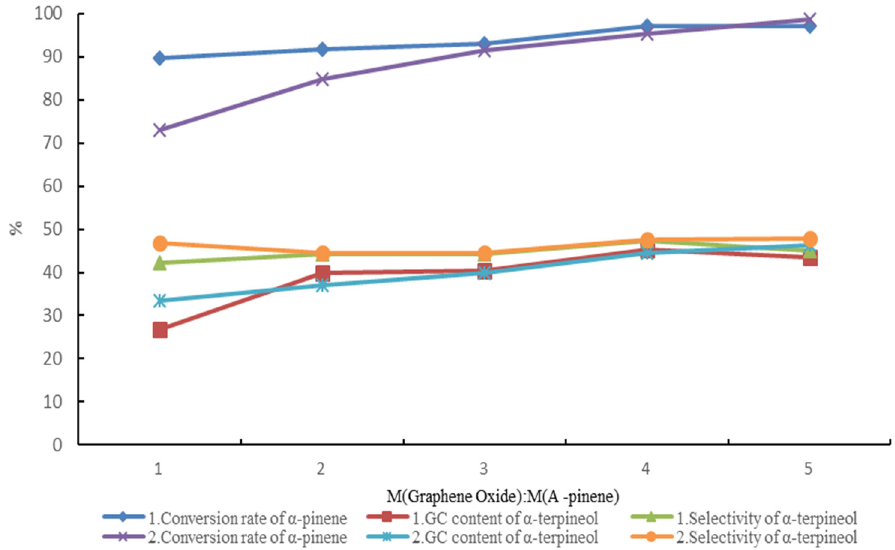
Figure 13. Hydration of alpha-pinene catalyzed by monolayer graphene oxide. Additionally, trichloroacetic acid was also compared with citric acid under the same ex- perimental conditions. Table 8 shows that citric acid as the catalyst increased the conversion of alpha-pinene by 6.6% compared with trichloroacetic acid. The content of alpha-pinene increased by 21.2%, and the selectivity of alpha-terpineol by 17%. Table 8. Citric acid, trichloroacetic acid, and phosphoric acid formed the composite catalysts. Catalyst Parmeters